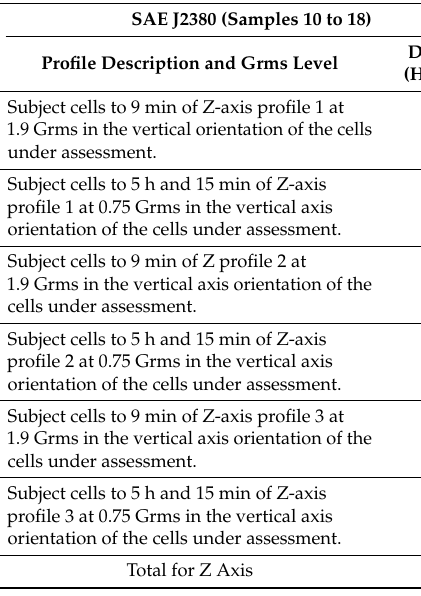
Table 3. X axis vibration profiles schedule.